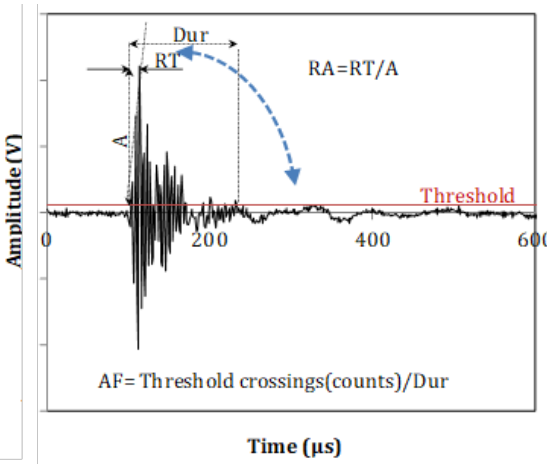
Figure 2. Typical AE waveform with main parameters.